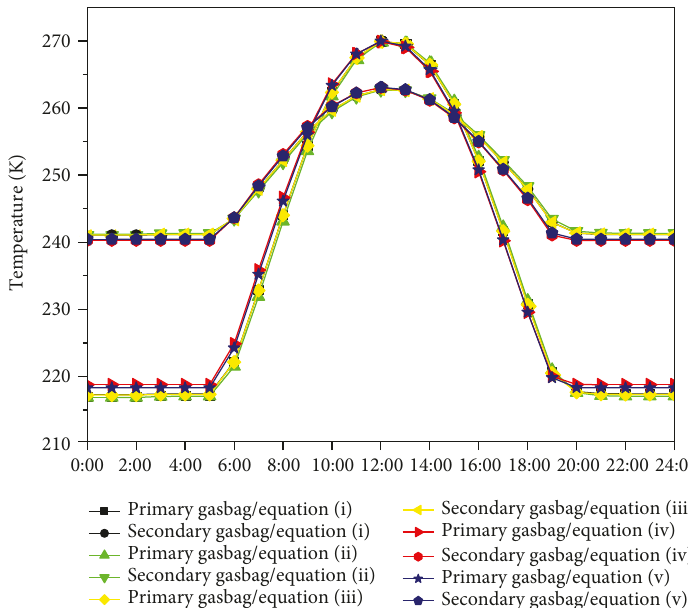
Figure 4: Helium gasbag temperatures calculated by di ff erent natural convection